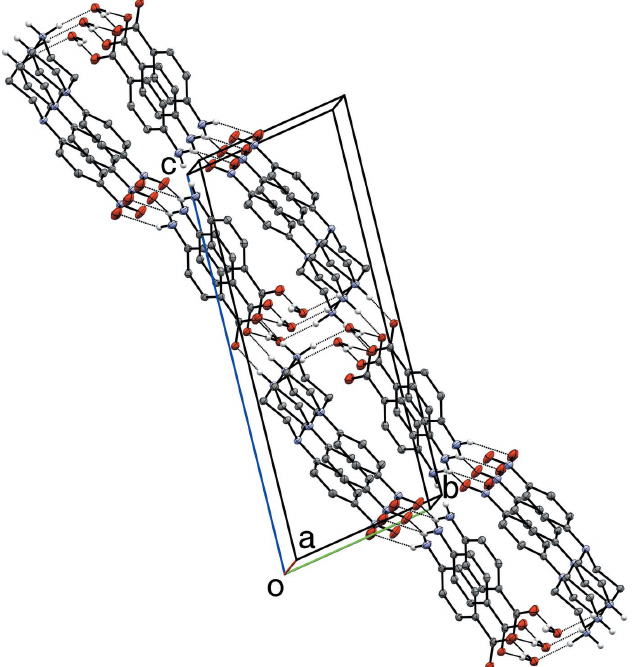
Figure 7 A partial packing plot of II showing N—H (cid:2)(cid:2)(cid:2) O and O—H (cid:2)(cid:2)(cid:2) O hydrogen- bonded (dotted lines) double layers that extend parallel to (011). Hydrogen atoms not involved in hydrogen bonds are omitted.